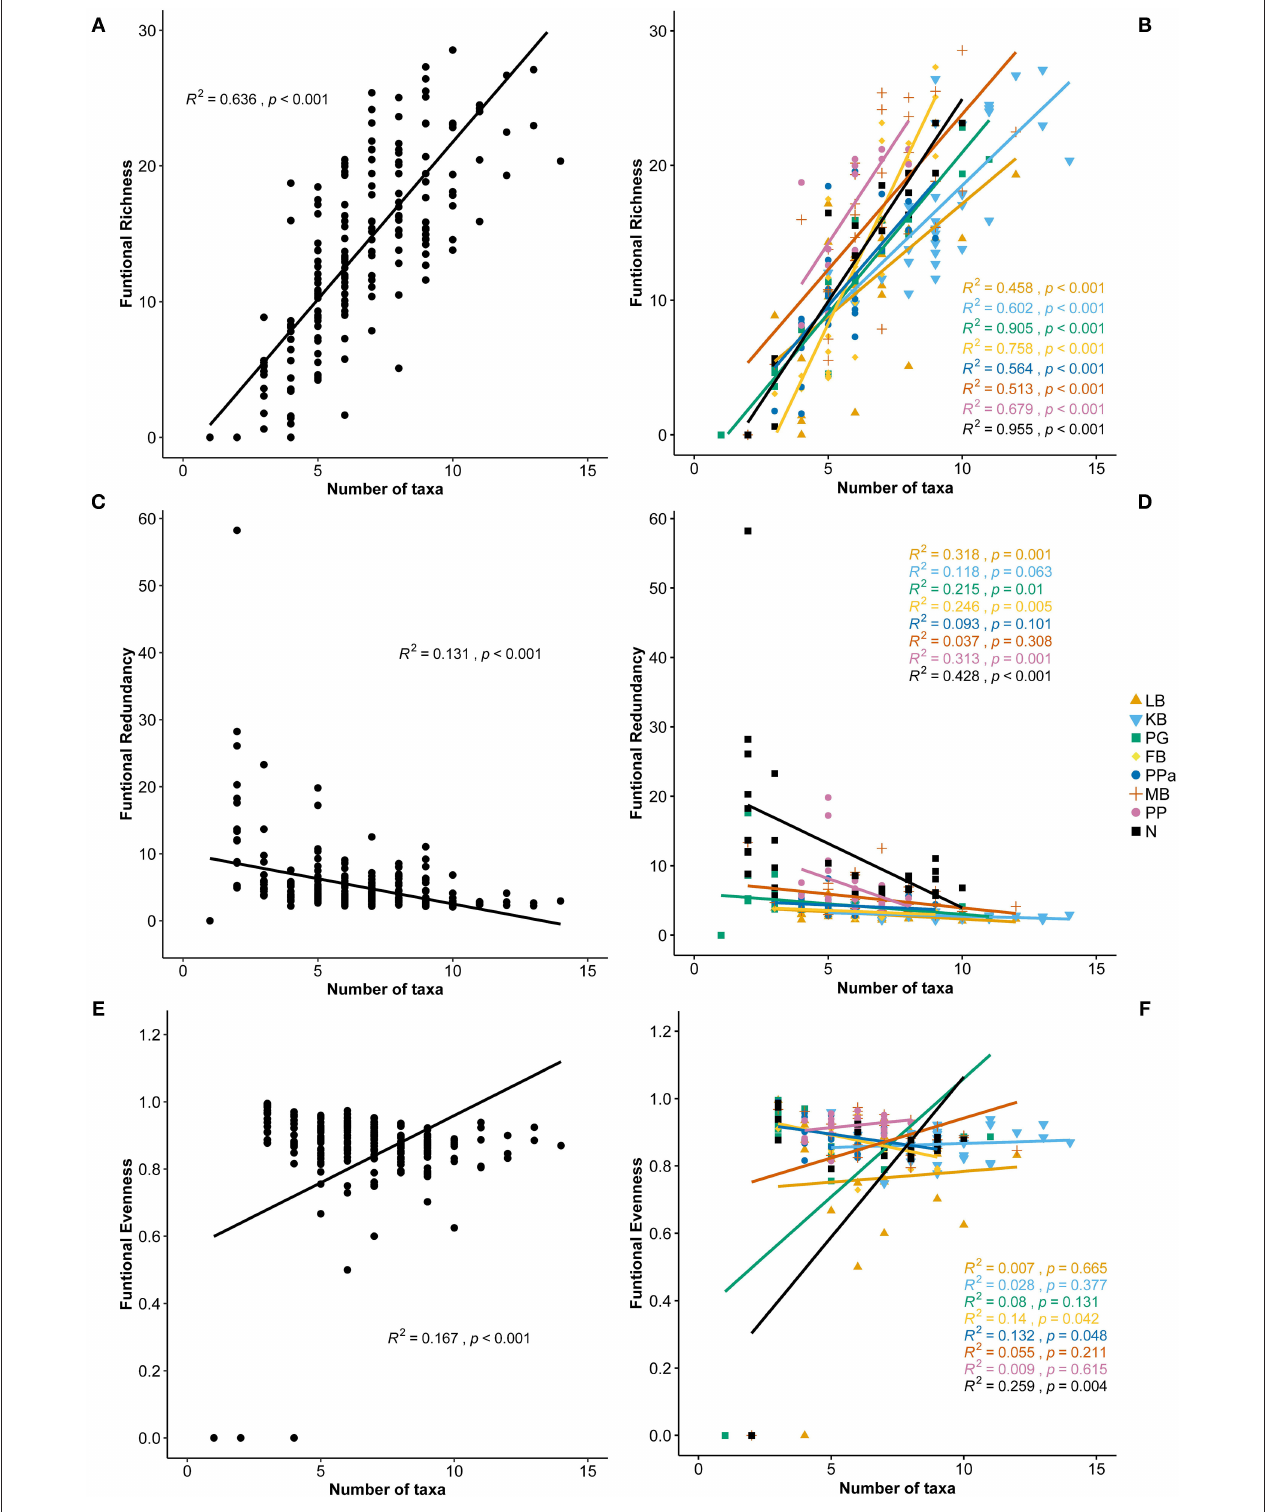
FIGURE 6 | Correlation plots between the number of taxa and (A) Functional Richness, (B) Functional Richness per site, (C) Functional Redundancy, (D) Functional Redundancy per site, (E) Functional Evenneness, and (F) Functional Redundancy per site. LB, Long Beach; KB, Kellidie Bay; MB, Middle Beach; PPa, Port Parham; PG, Port Germein, FB, Fisherman Bay; PP, Pelican Point; N, Noonameena.